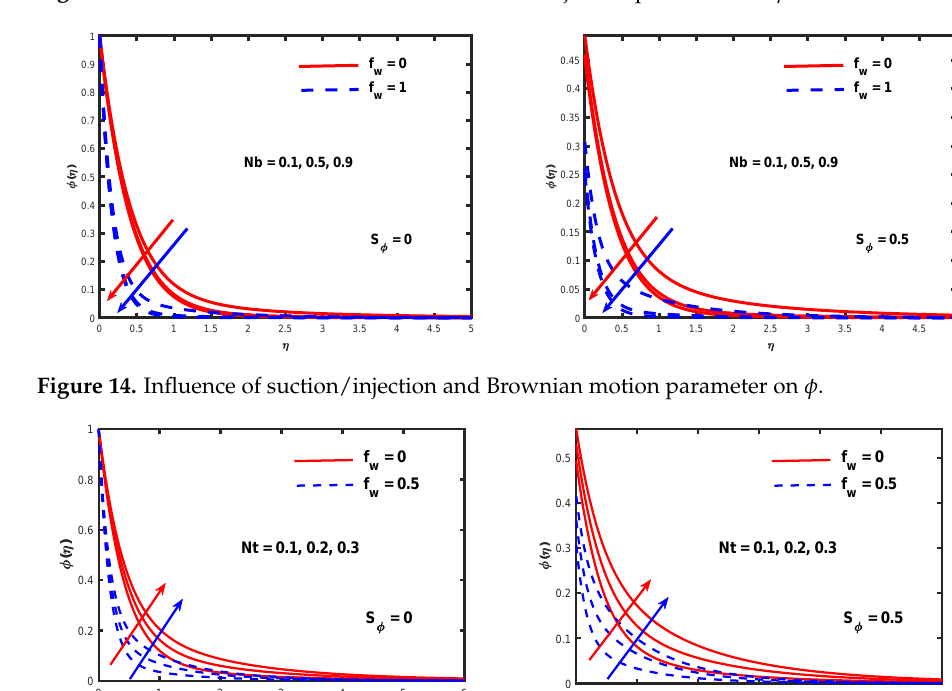
Figure 13. Influence of Lewis number and suction/injection parameter on φ .